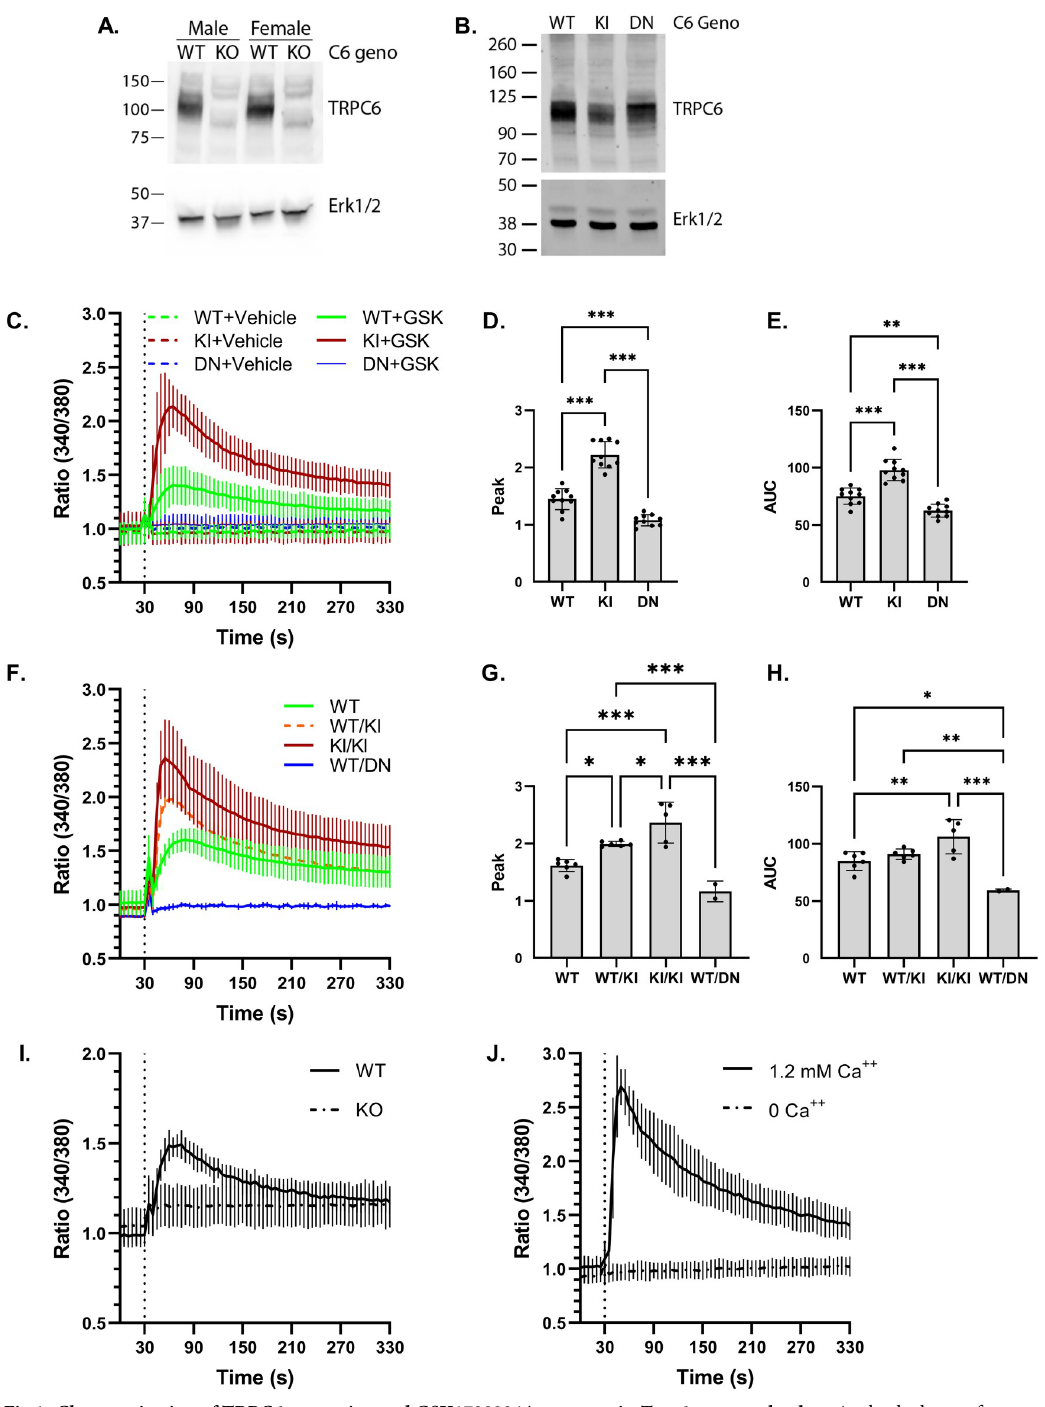
Fig 1. Characterization of TRPC6 expression and GSK1702934A response in Trpc6 mutant platelets. A, platelet lysates from wild-type (WT) and Trpc6 -/- (KO) littermate mice were analyzed by SDS-PAGE and western blot. Anti-TRPC6 antibodies (top) detected a major band around 105 kD in WT but not KO mice. Erk1/2 blot (bottom) is shown as a loading control. B, platelet lysates obtained from wild-type (WT), Trpc6 E896K/E896K (KI), and Trpc6 DN/DN (DN) mice were subject to western blot using antibodies against TRPC6, and Erk1/2. C, time-course of Fura-2 fluorescence ratio (340/380) in WT, KI and DN platelets. Platelets were treated with GSK (final concentration 50 μ M) or DMSO vehicle after 30 seconds (dashed vertical line). N = 8–10 using platelets from 4–6 mice per genotype. D, peak post-stimulation Fura-2 fluorescence ratios from GSK-stimulated traces shown in (C). One-way ANOVA with Tukey’s multiple comparisons test. E, area under the curve (AUC, arbitrary units) of the Fura-2